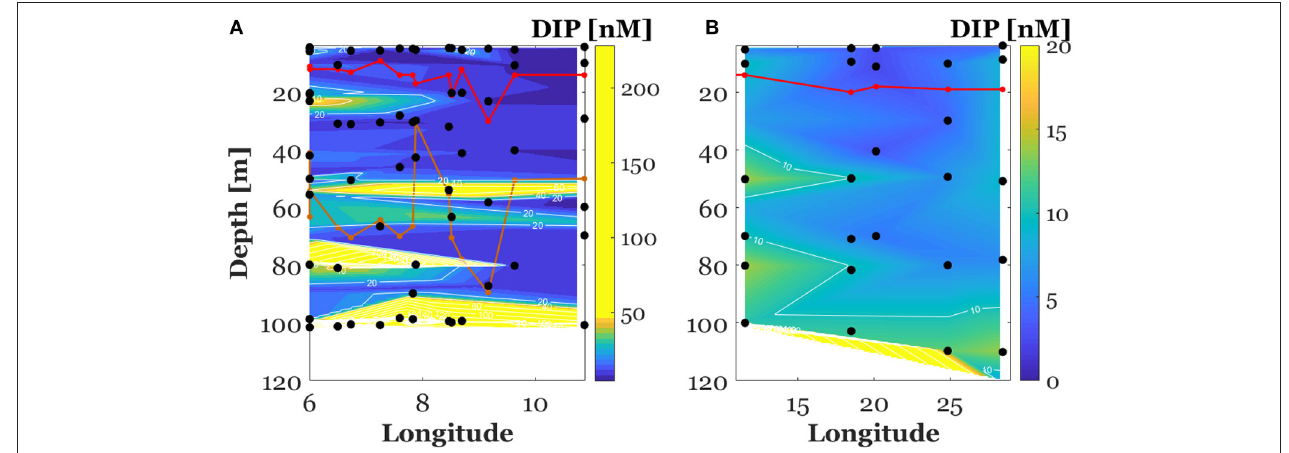
FIGURE 3 | Vertical section of dissolved inorganic phosphate concentrations (DIP) in the North Western Mediterranean Sea (between the surface and 100m, A ) and along the E-W transect crossing Ionian and Tyrrhenian seas (between the surface and 120m, B ). The red plot represents the mixed layer depth. The orange plot represents the phosphacline depth. Note that the scale of the color bar has been tightened to point out the positive gradient of DIP in the North Western Mediterranean Sea.